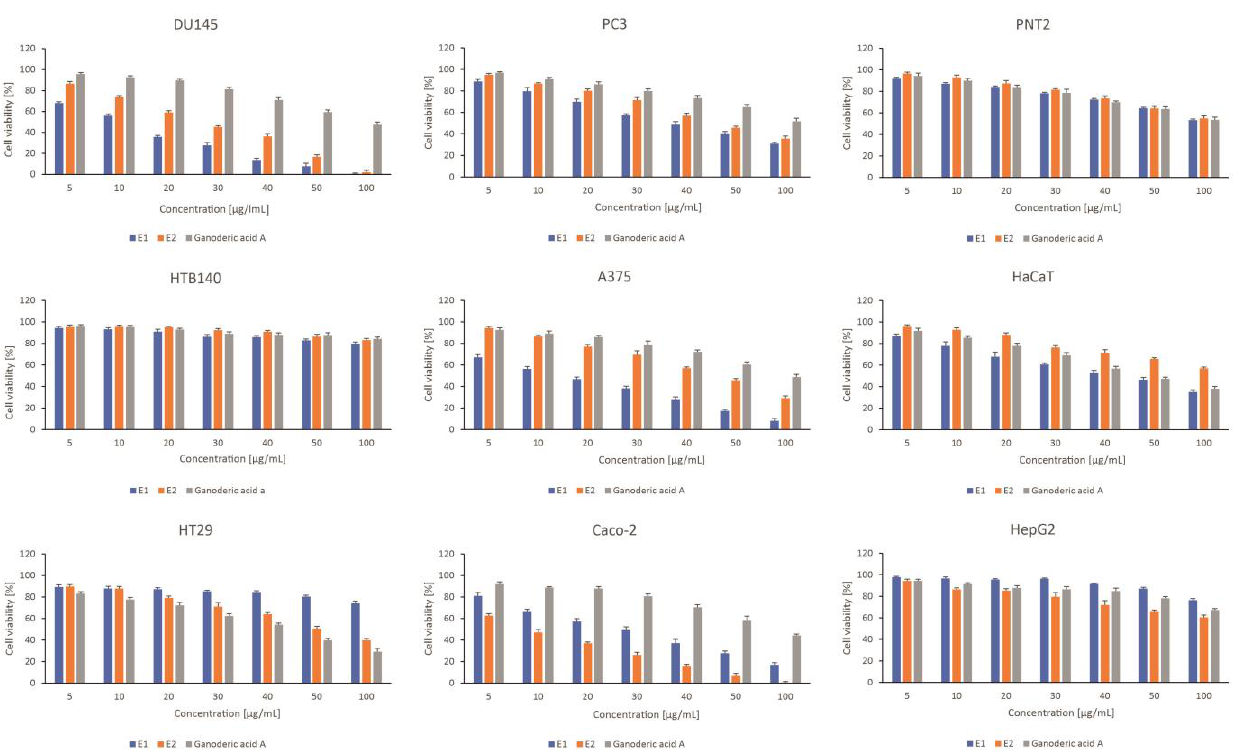
Figure 4. The effect of Ganoderma applanatum extracts on viability of prostate cell line panel—DU145, PC3, and PNT2; skin cell line panel—A375, HTB140, HaCaT, and gastrointestinal tract cell lines panel—Caco-2, HT29, HepG2. Cells were treated with E1—control or extract; E2– extract obtained after elicitation (variant corresponding to the highest concentration of triterpenes) and standard substances: ganoderic acid A ( n = 3). Values are presented as the mean ± SD (standard deviation). Significant differences are shown in Tables S1–S3 (Supplementary Materials).